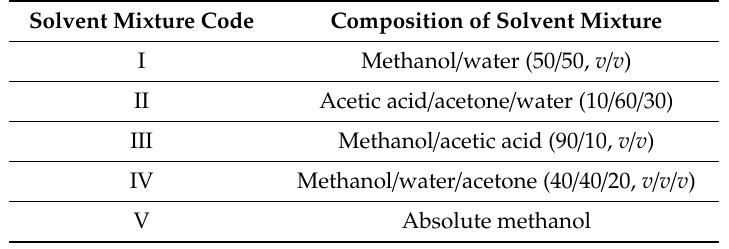
Table 1. Solvent mixtures tested to maximize extraction of total